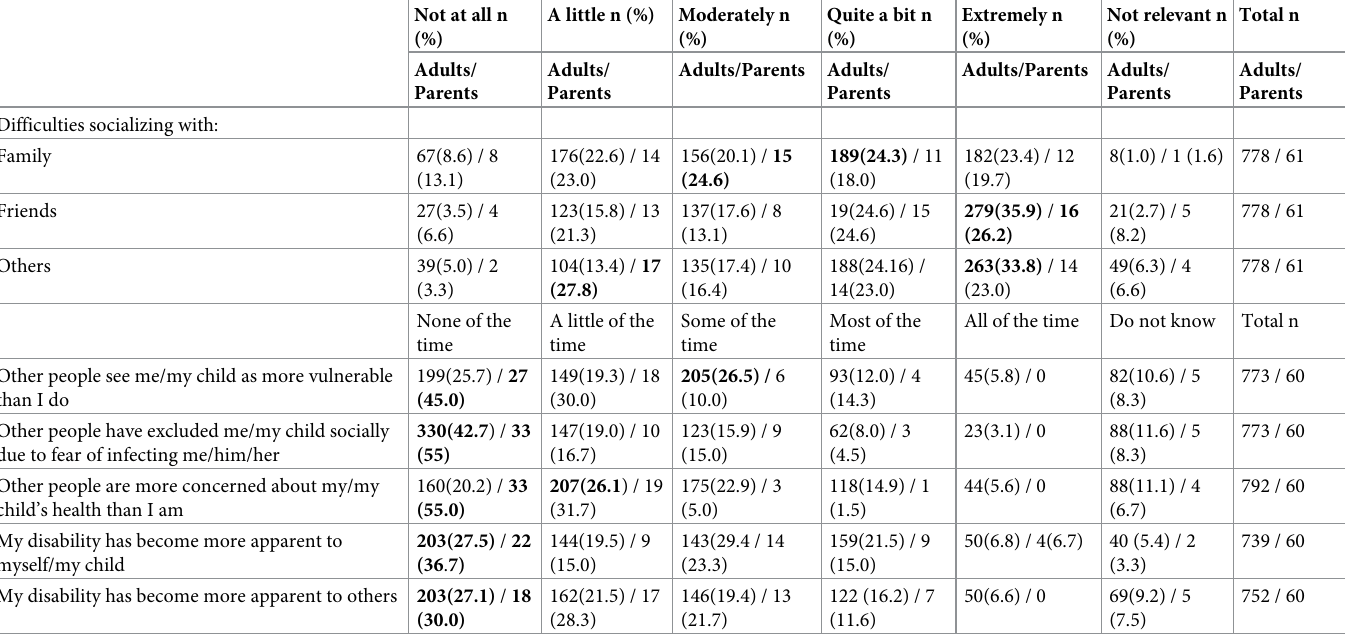
Table 6. Difficulties socializing and perception of